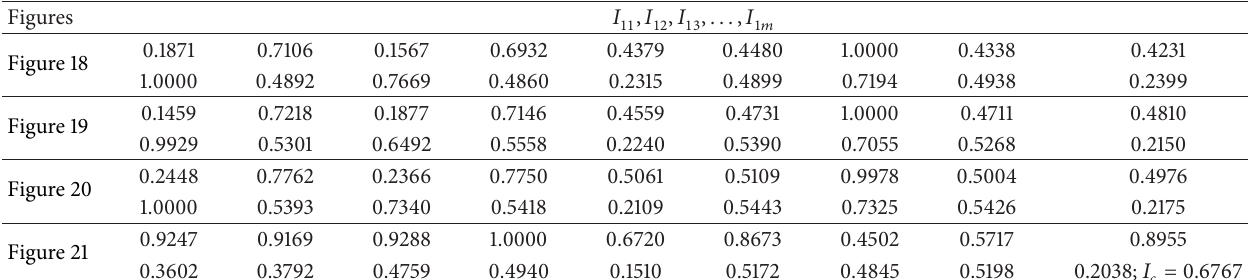
Table 5: The amplitude values calculated by BSA for pattern nulling synthesis